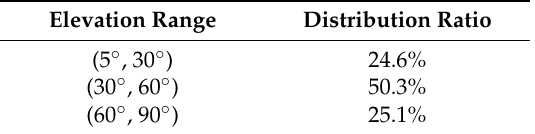
Table 5. Average distribution of the optimal satellite subsets under the brute method.